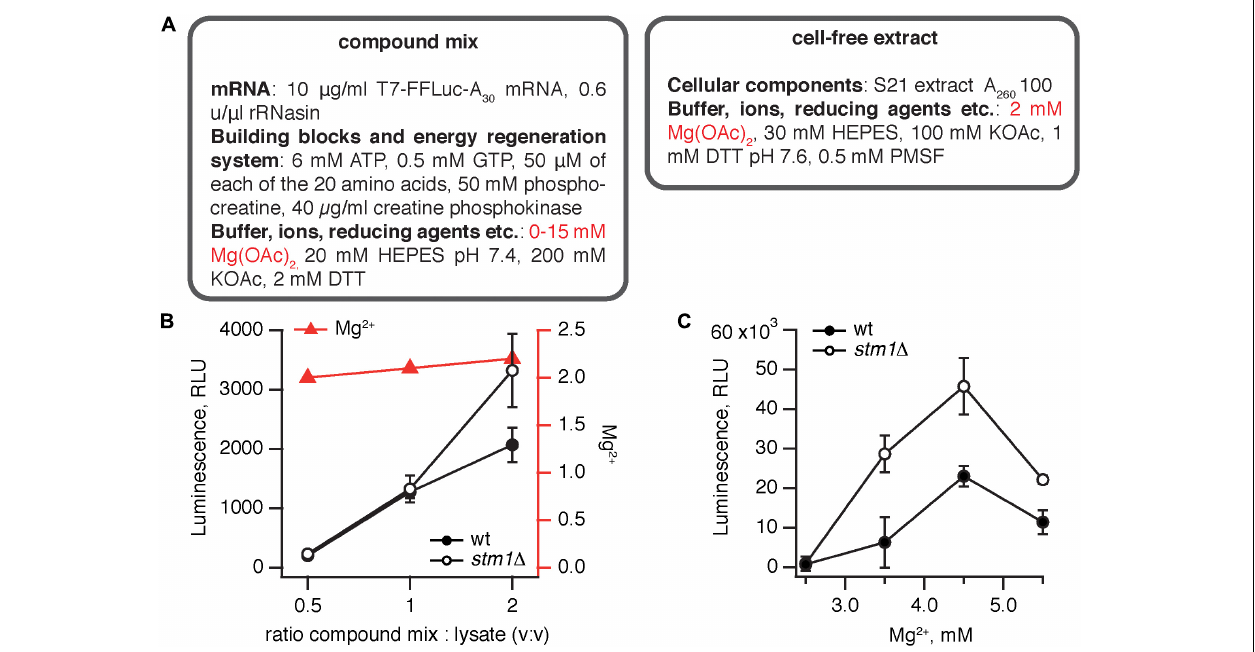
FIGURE 2 | Elimination of Stm1 improves the efficiency of S. cerevisiae translation system. (A) A cell-free translation system was assembled by combining the compound mix with the cell-free extract. The efficiency of translation was quantified by the activity of firefly luciferase using the Steady-Glo Luciferase Assay (Promega). Titrations of the compound mix to cell-free extract ratio (B) and magnesium ion concentration (C) in the cell-free translation system. Luminescence readings were taken after incubation for 1 h at 25 ◦ C. Error bars indicate the standard error of the geometric mean of biological replicates, i.e., independently prepared cell-free extracts ( n ≥